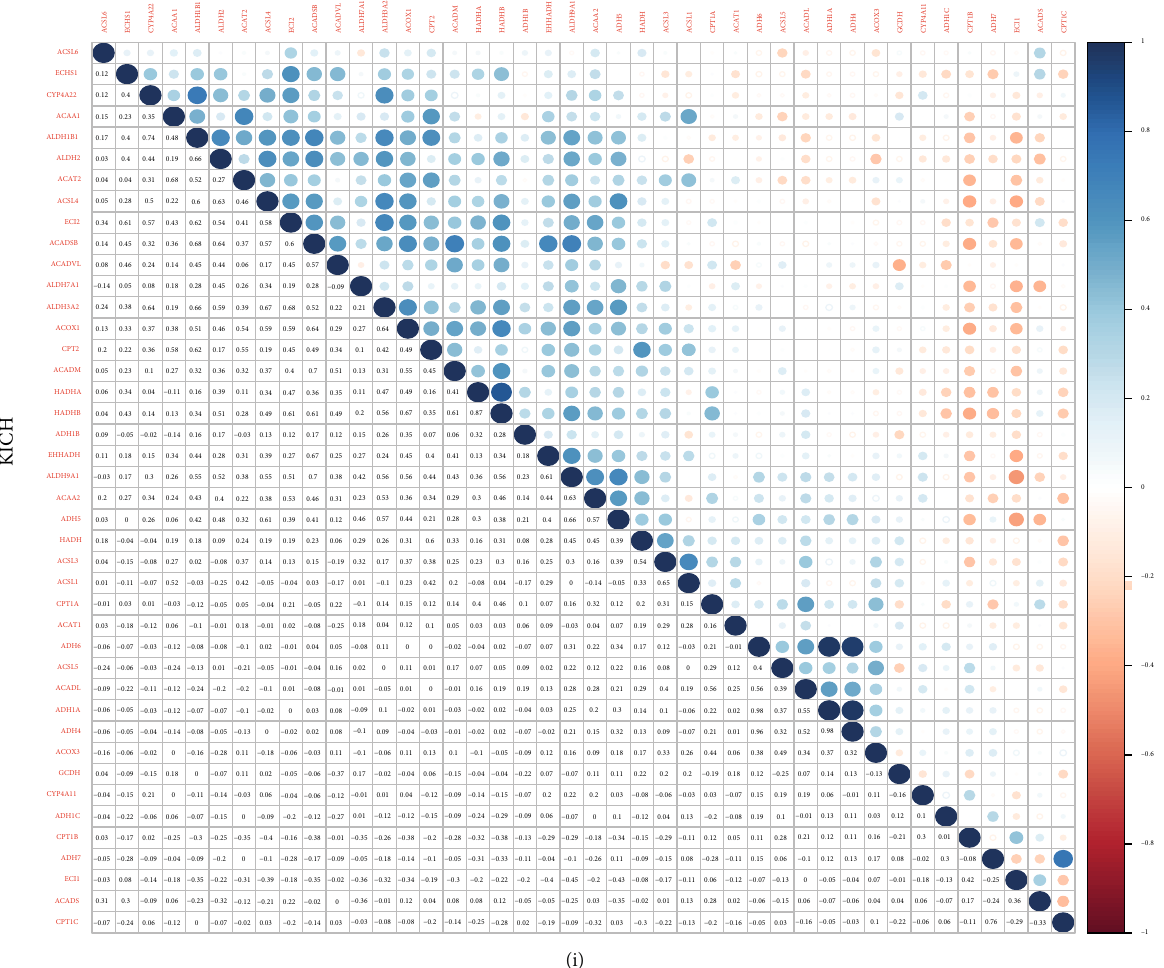
Figure 4: Correlation between two fatty acid metabolism genes in pan-renal cell carcinoma. (a, d, g) Expression of fatty acid metabolism- related genes between cancer tissues and normal tissues in KIRC, KIRP, and KICH. The redder the color, the higher the expression. The greener the color, the lower the expression. (b, e, h) Univariate analysis of fatty acid metabolism-related genes in KIRC, KIRP, and KICH. When the hazard ratio of this gene is > 1, it means that the gene is a risk factor in the corresponding tumor and vice versa. (c, f, i) Correlation analysis of fatty acid metabolism-related genes in KIRC, KIRP, and KICH. Red represents a positive correlation and blue represents a negative correlation. ∗ P < 0 : 05 , ∗∗ P < 0 : 01 , and ∗∗∗ P < 0 : 001